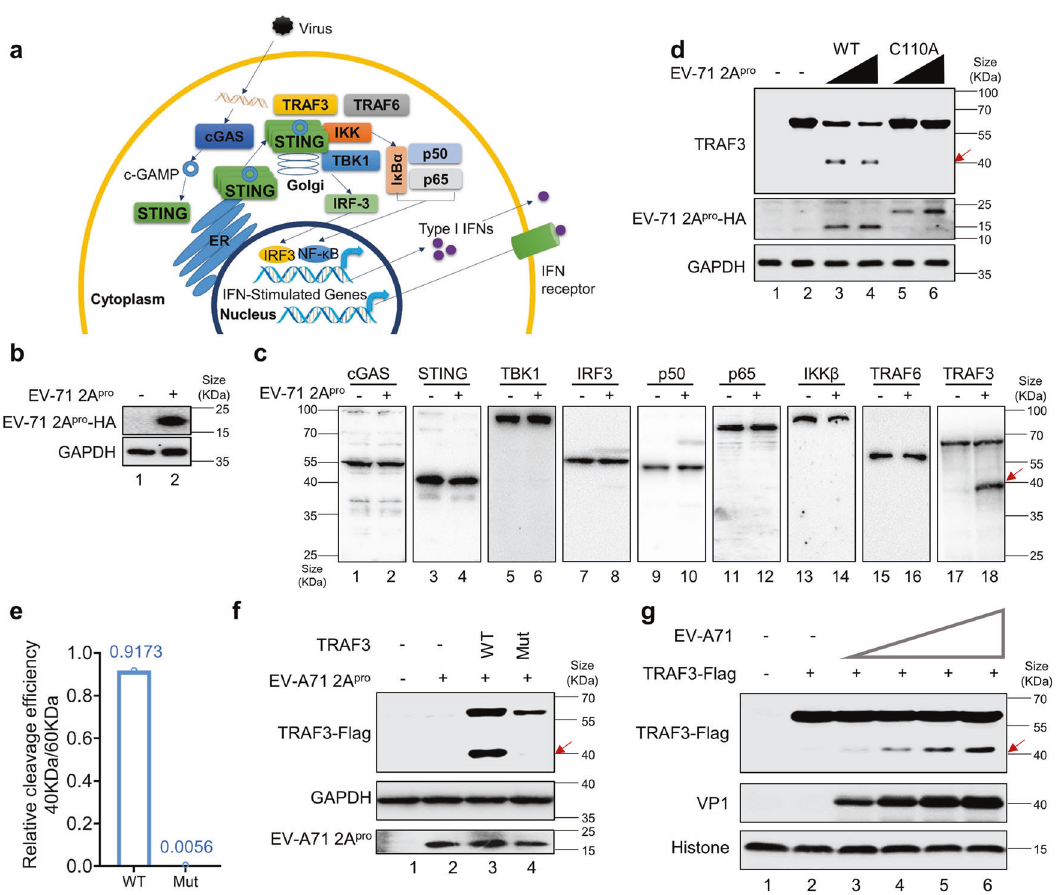
Fig. 4 TRAF3 is a target of EV-A71 2A pro . a Schematic diagram of the process of cGAS-STING activation and factors involved. b HEK-293T cells were transfected with empty vector or EV-A71 2A pro- expressing vectors. Eighteen hours post-transfection, cells were harvested for western blot analysis. Anti-HA was used to identify EV-A71 2A pro . GAPDH was used as a loading control. c HEK-293T cells were transfected with empty vector or EV-A71 2A pro -expressing vectors ( b ), cGAS, and STING expressing vectors. Eighteen hours post-transfection, cells were harvested